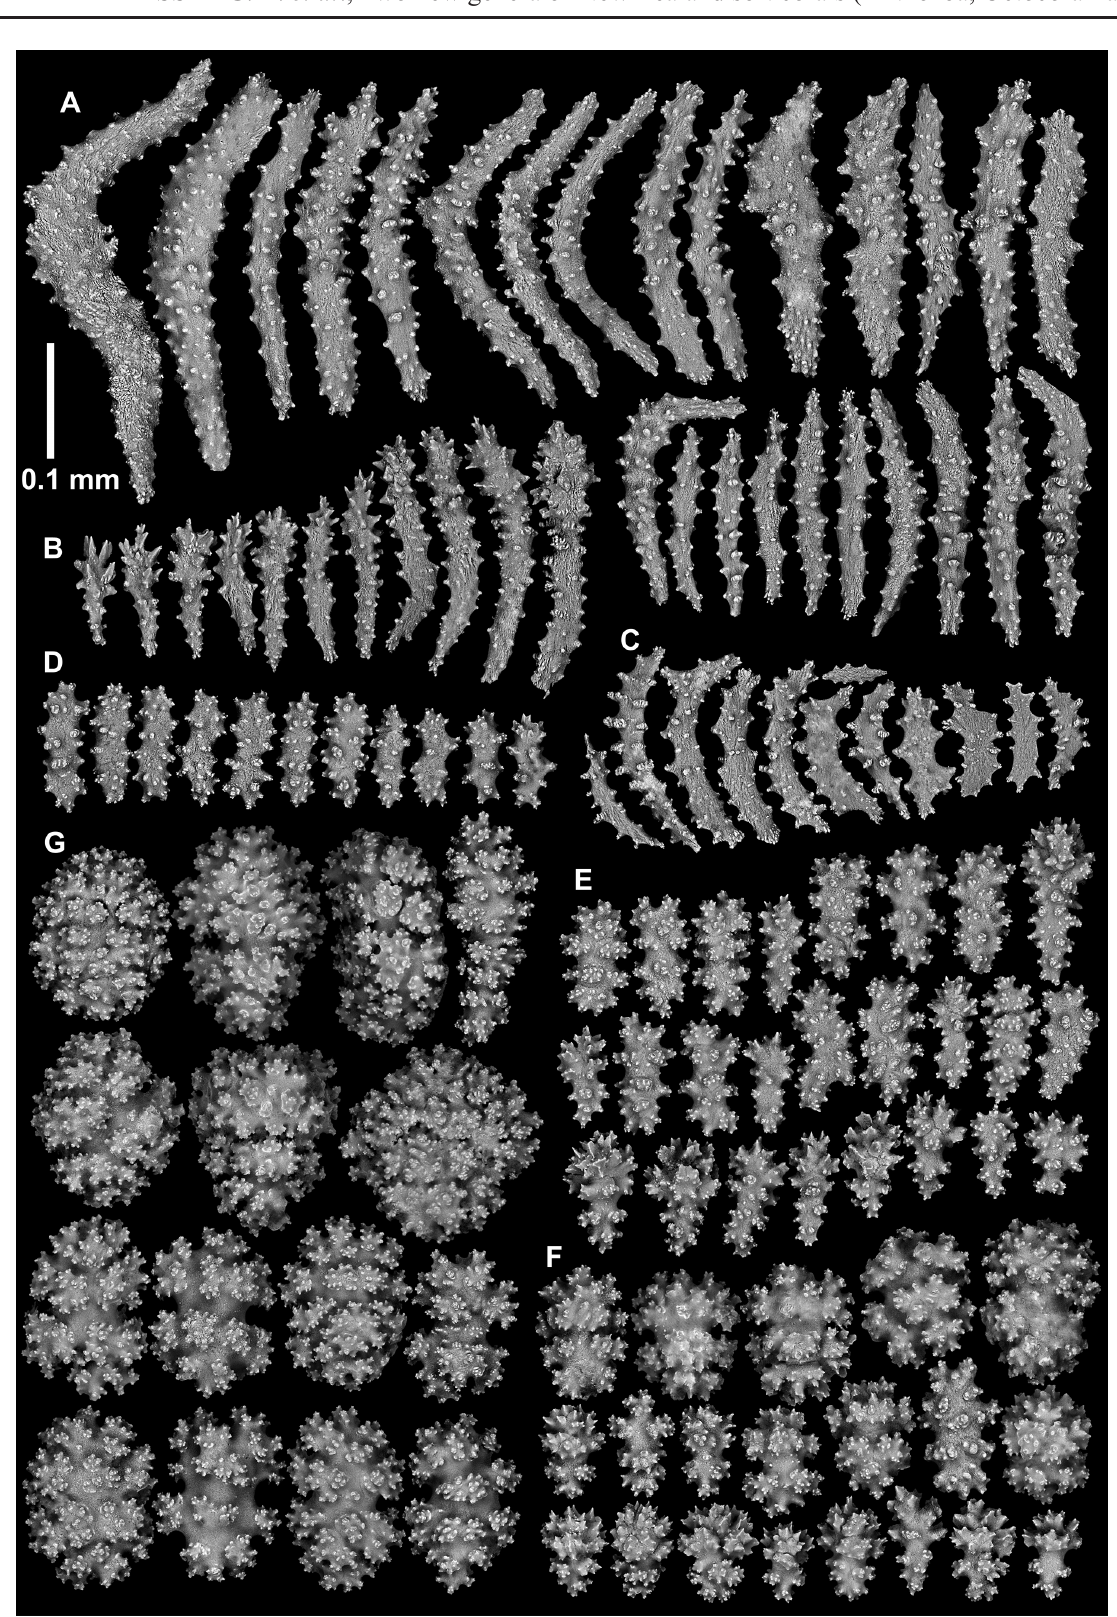
Fig. 22. Kotatea niwa gen. et sp. nov., holotype (MAGNT C015226), SEMs of sclerites. A . Collaret and points. B . Distal points. C . Tentacles. D . Polyp neck. E . Polyp mound. F . Lobe surface. G . Lobe